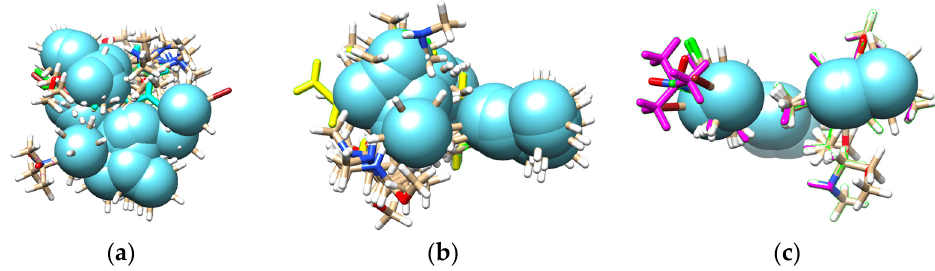
Figure 4. Representative view of pharmacophore groups (light blues) for the three data sets: set1 ( a ), set2 ( b ), set3( c ): ( a ) (diazepam cyan), ( b ) (NBQX yellow), and ( c ) ( 2b magenta), respectively.